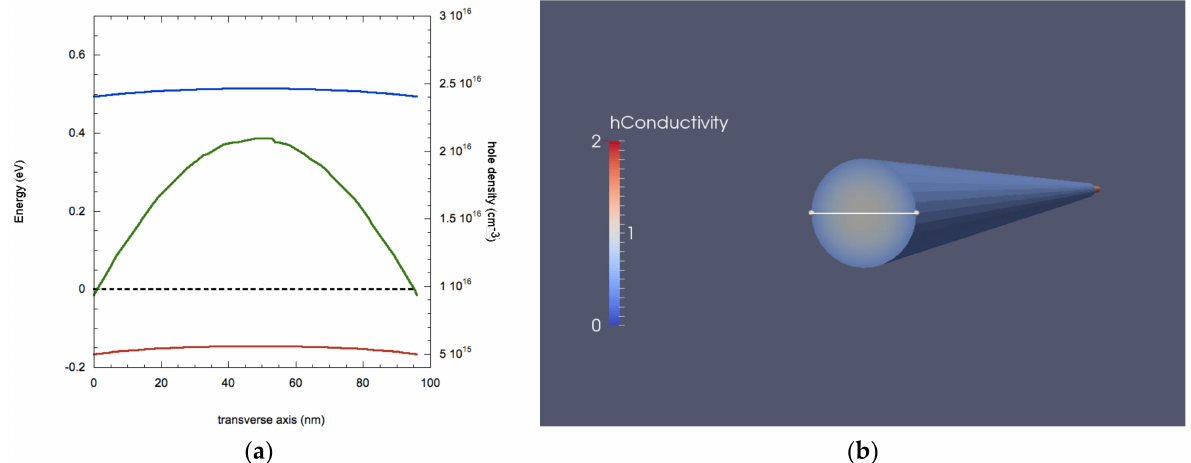
Figure 5. ( a ) Values for energy bands (blue: bottom of conduction band, red: peak of valence band), Fermi level (dashed black line), and carrier density (green line) along the transverse axis with additional p surface charges. ( b ) Transverse section of a 3D plot of conductivity.